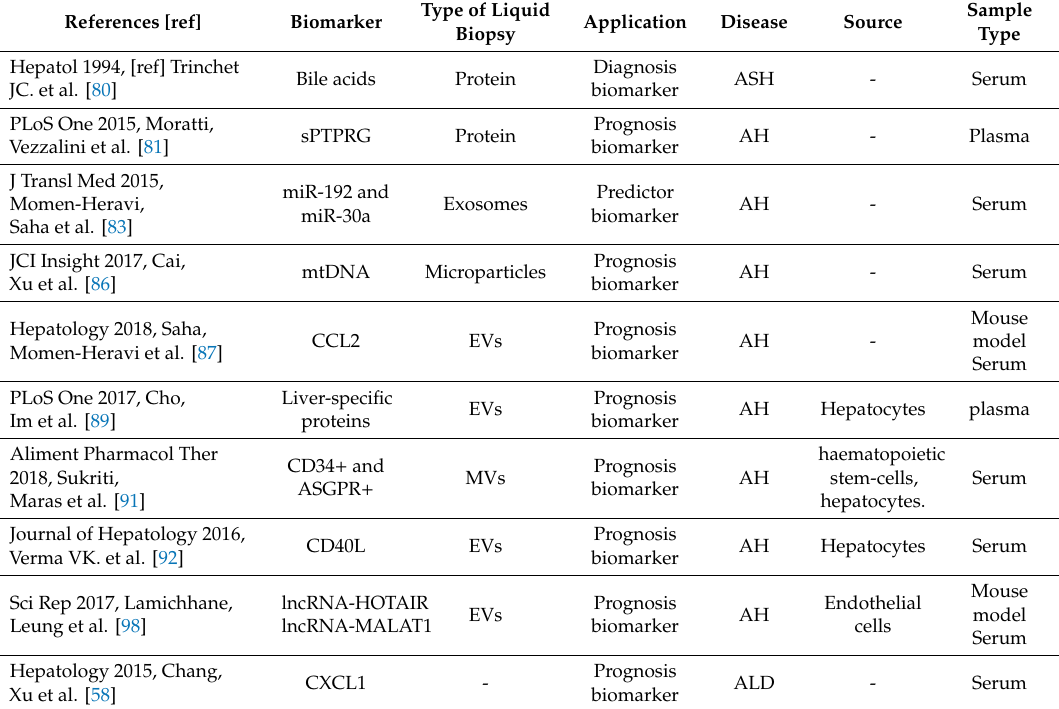
Table 3. Liquid biomarkers of alcoholic liver